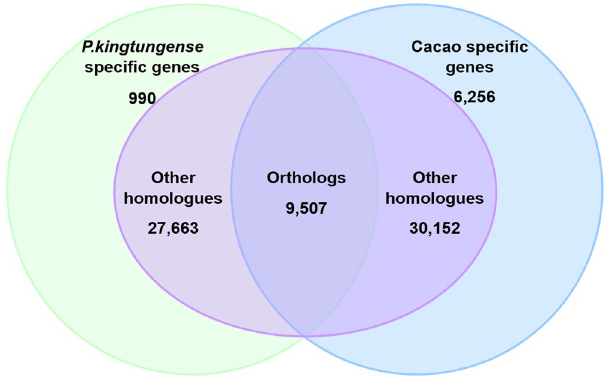
Figure 2. The results of bidirectional blast between P. kingtungense and cacao.